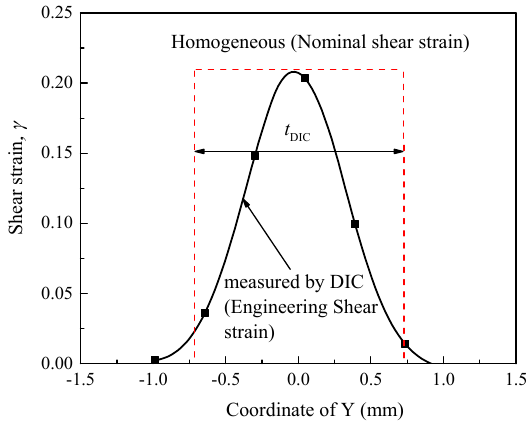
Figure 9. Schematic representations of nominal shear strain calculation.